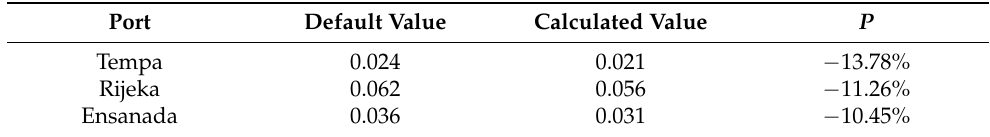
Table 3. Excellent service capacity ports.